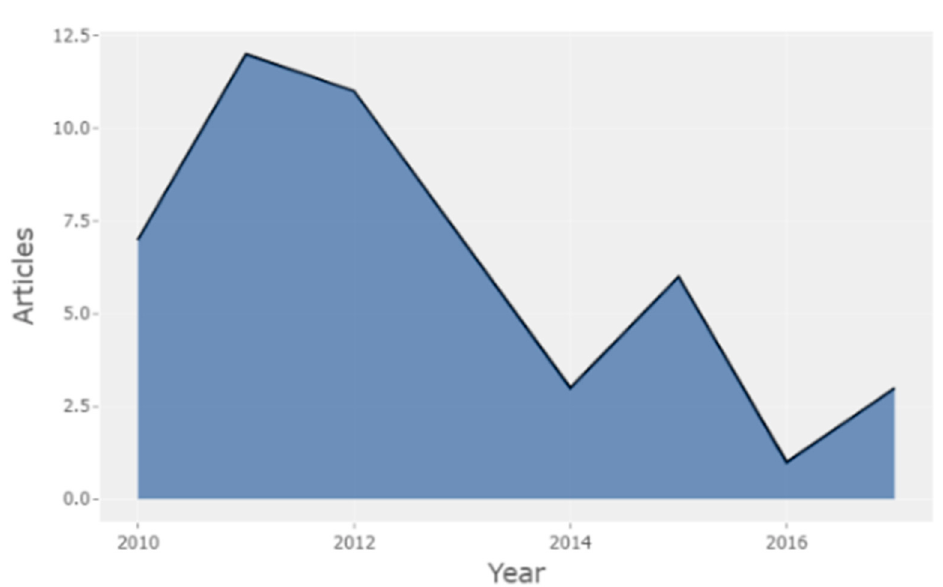
Figure 1. Distribution of publications by year and record count.